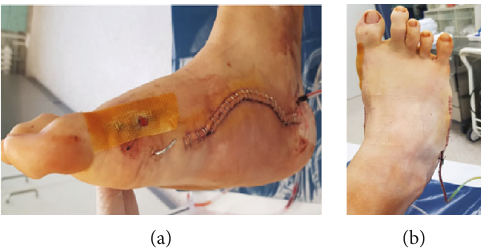
Figure 7: Postoperative photographs of the medial (a) and dorsal (b) side of the foot, displaying the wound with skin staples, a drain, a K- wire, fatty gauze covering the hallux metatarsophalangeal joint approach, and laterally abducted fi fth toe.